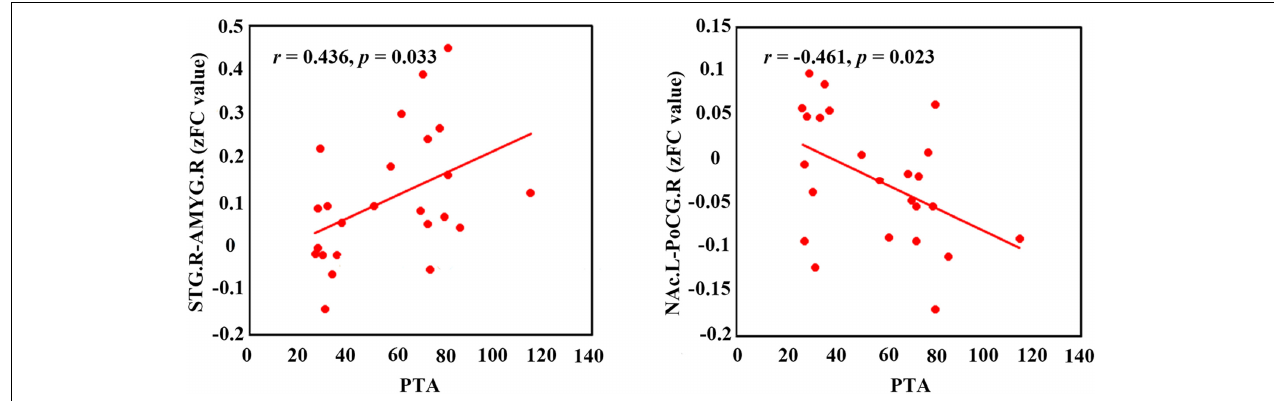
FIGURE 4 | The correlations between the FC with significant group-difference and PTA in the ISSNHL patients. The red dots represent each ISSNHL patient. FC, functional connectivity; PTA, pure tone audiometry; STG, superior temporal gyrus; AMYG, amygdala; NAc, nucleus accumbens; PoCG, postcentral gyrus; left hemisphere; R, right